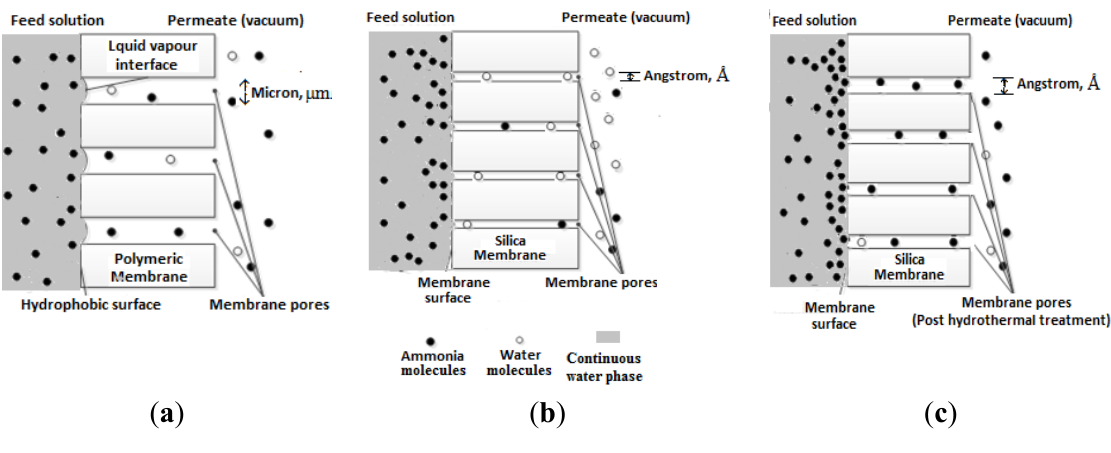
Figure 2. A comparison of ammonia transport mechanisms through membranes: ( a ) the porous hydrophobic membrane (pore size range of micrometres); ( b ) the ammonia rejective molecular sieve silica membranes (pore size range of angstroms); and ( c ) the ammonia passive silica membranes (pore size range of